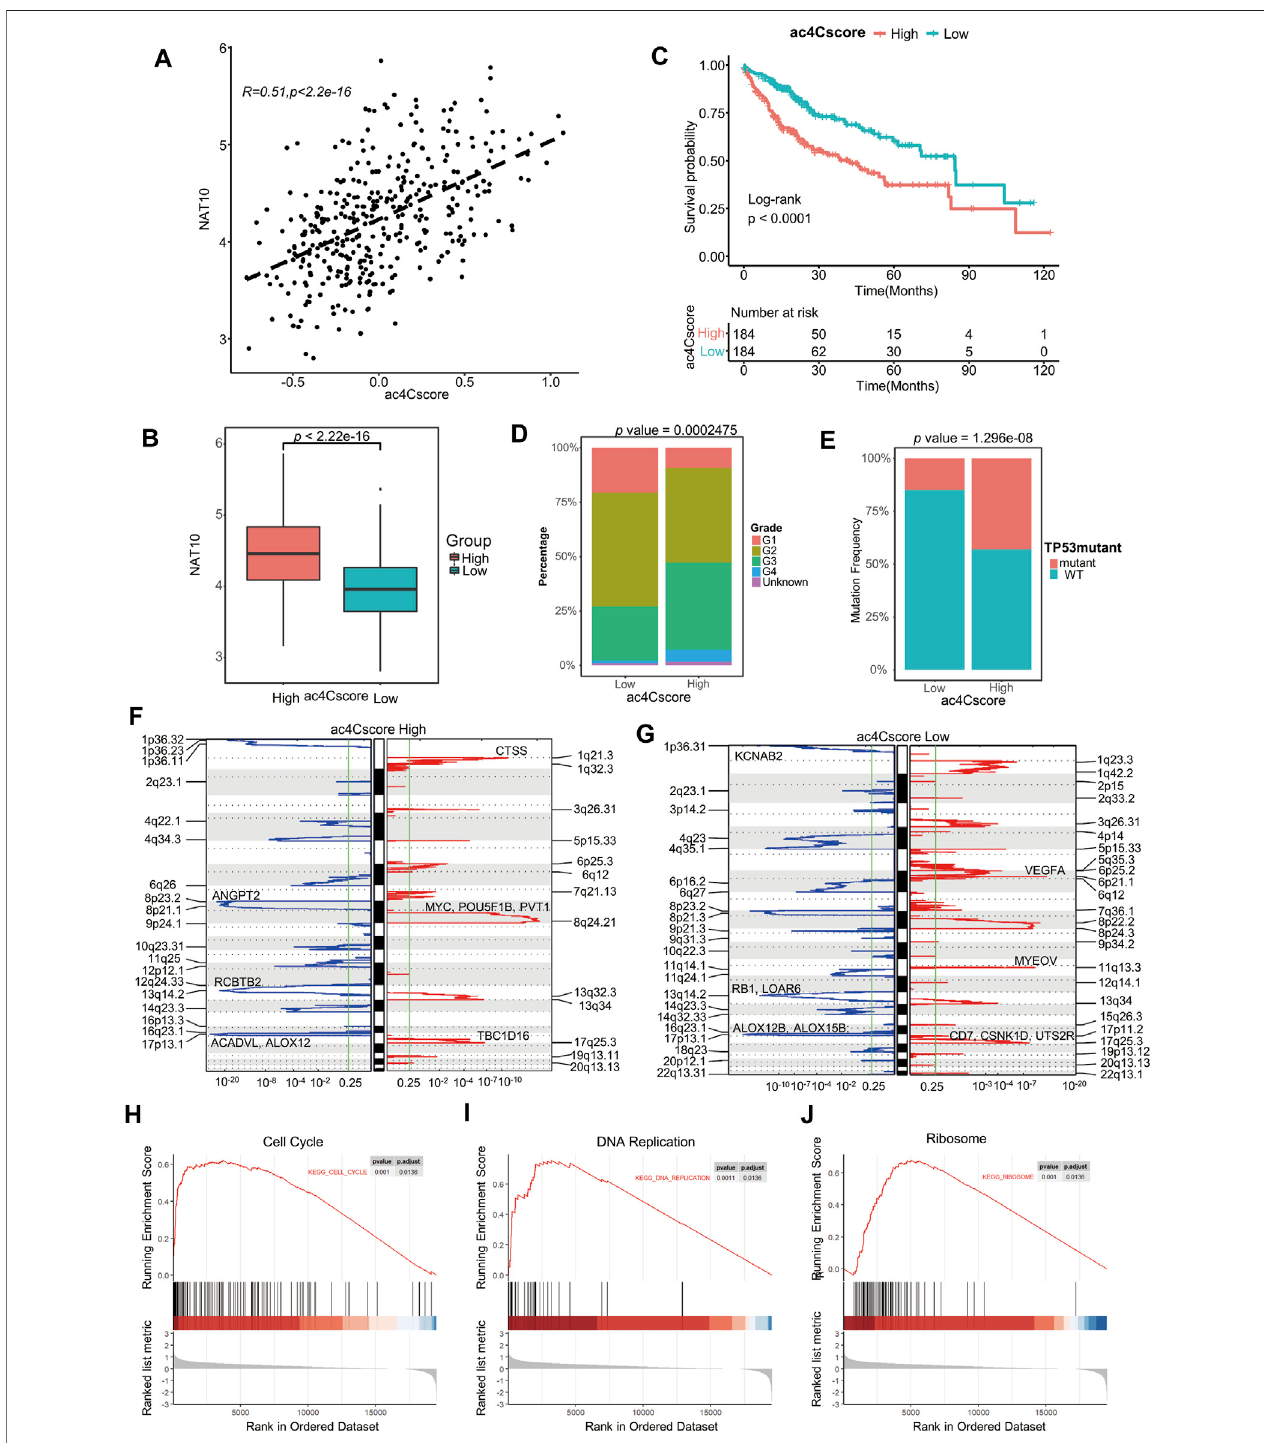
FIGURE 3 | Construction of the ac4Cscore model and different biological characteristics of groups. (A) Correlation of ac4Cscore and expression of NAT10. Pearson correlation coef fi cient with p value < 0.05 is considered signi fi cant. (B) The expression of NAT10 between the ac4Cscore high and low groups. T test with p value < 0.05 is considered signi fi cant. (C) Survival analysis for ac4Cscore groups. Kaplan-Meier curves with log-rank p values < 0.05 are considered signi fi cant. (D) Proportion of tumor grade in the ac4Cscore groups. (E) Proportion of patients with or without TP53 mutations in the ac4Cscore groups. Fisher ’ s exact test with p value < 0.05 is considered signi fi cant. (F, G) Signi fi cantly altered CNV regions of ac4Cscore high and low groups determined by GISTIC2. The left two panels show the pro fi les oftheac4Cscorehigh group, and theright twopanelsshow thepro fi les ofthe lowgroup.Thepanelwiththered lineindicates ampli fi cation regions,and theblue line indicates deletion regions. (H – J) GSEA plots show the upregulated genes in the ac4Cscore high group enriched in the cell cycle, DNA replication and ribosome pathways. A strict criterion with p value < 0.01 and adjusted p value < 0.05 is considered signi fi cant.